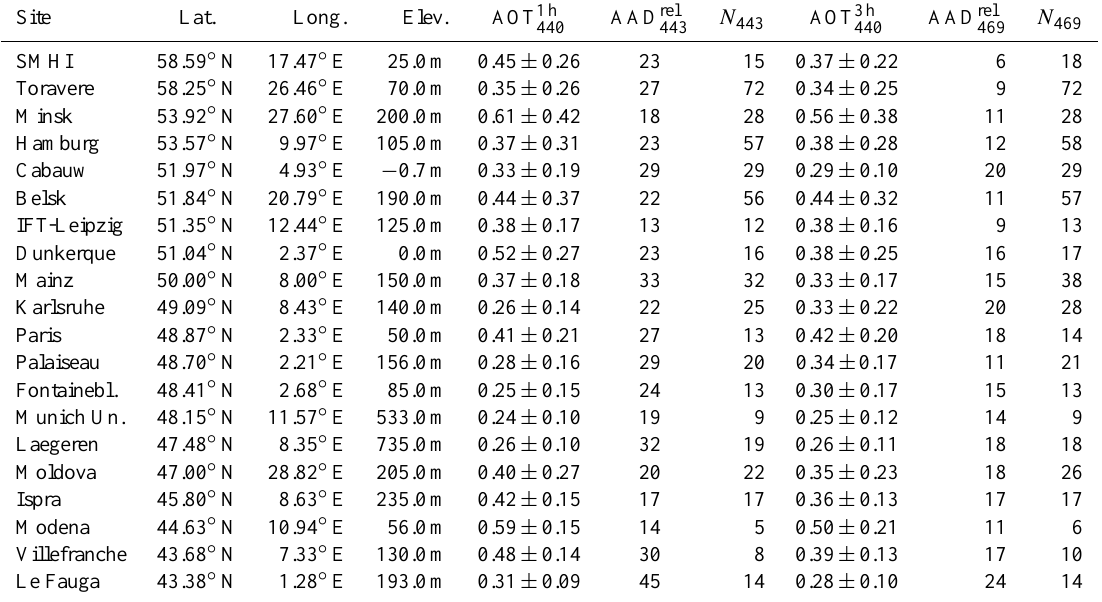
Table 1. Mean aerosol optical thickness (AOT) from AERONET at 440nm averaged according to 1h (SAER) and 3h (MODIS). Rela- tive average absolute deviation (AAD rel , in percent) between AERONET and SAER as well as MODIS c005 for AOT at 443 and 469nm, respectively, and number of collocations ( N ) for each AERONET site separately.